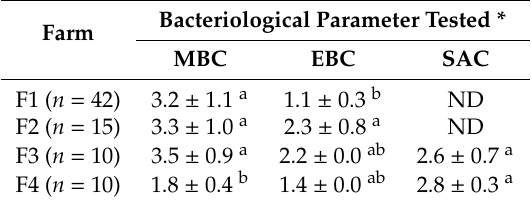
Table 5. Bacteriological quality of individual raw milk samples according to the farm. Farm